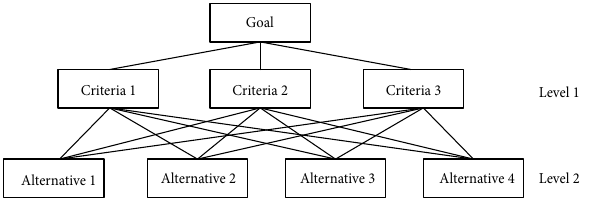
Figure 2. Hierarchical example in